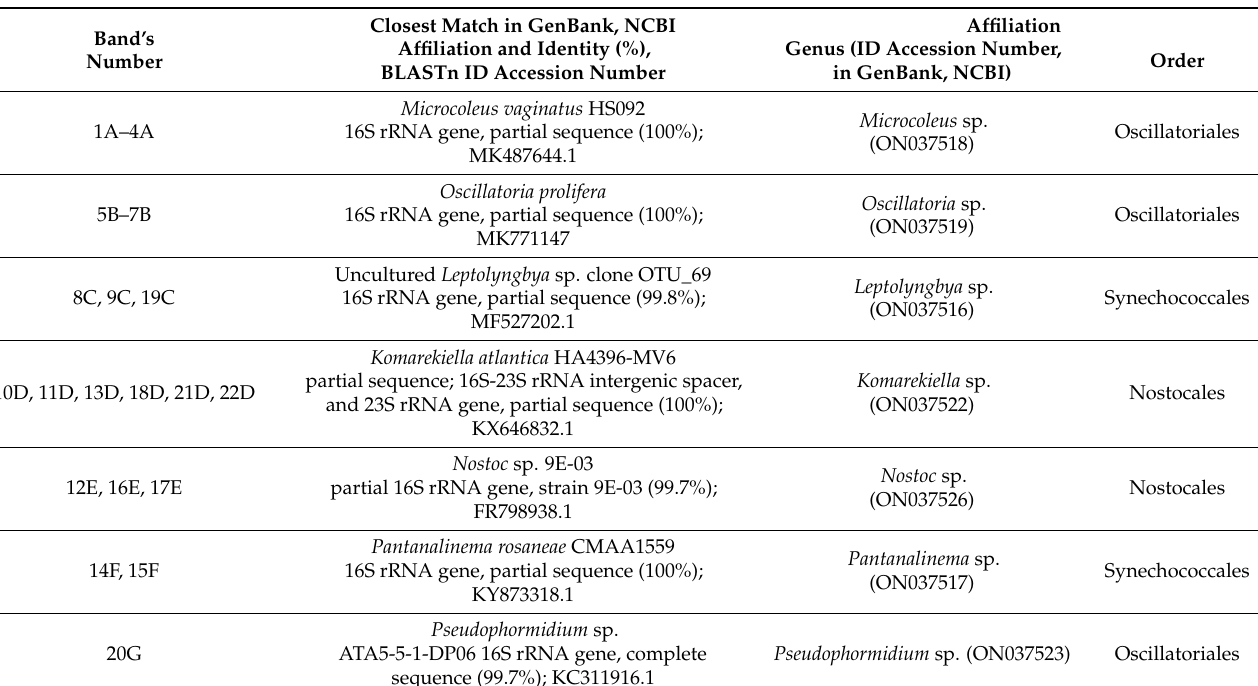
Table 1. The structure of the cyanobacterial communities of the roots of leafless orchids, Microcoelia moreauae and Chiloschista parishii , profiled with DGGE and followed with16S rDNA sequences. Closest Match in GenBank,